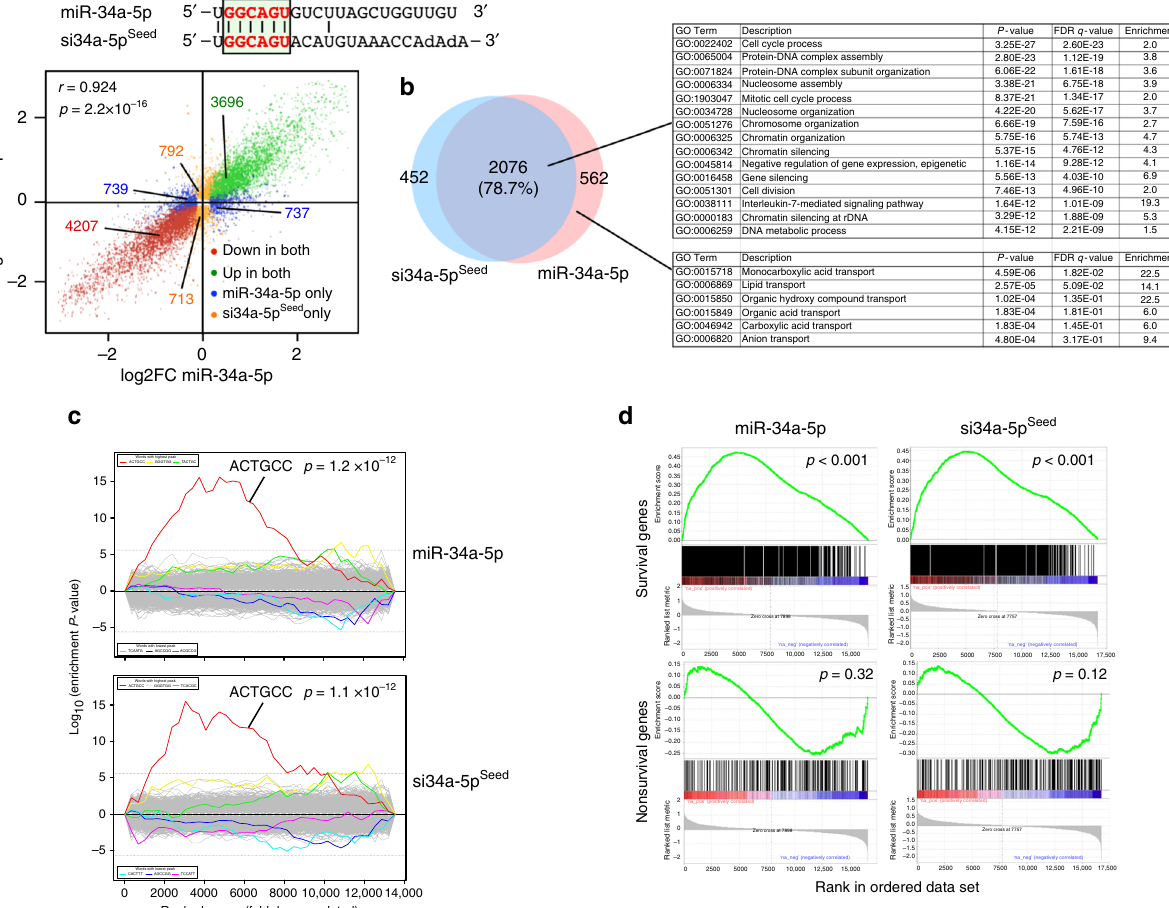
Fig. 5 miR-34a-5p kills cancer cells through its toxic 6mer seed. a Top: Alignment of the sequences of miR-34a-5p and si34a-5p Seed with the 6mer highlighted. Bottom: Comparison of deregulated mRNAs (adjusted p < 0.05, RPM > 1) in HeyA8 cells 48 h after transfection with either miR-34a-5p or si34a-5p Seed . Pearson correlation p -value is given. b Overlap of RNAs detected by RNA-Seq downregulated in HeyA8 cells (>1.5-fold) 48 h after transfection with either si34a-5p Seed or miR-34a-5p when compared to either siNT2 or a non-targeting pre-miR, respectively. Right: Results of a GOrilla gene ontology analyses of the genes downregulated in both cells transfected with miR-34a-5p or si34a-5p Seed (top, signi fi cance of enrichment <10 − 11 ), or only in cells transfected with miR-34a-5p (bottom, signi fi cance of enrichment <10 − 4 ). c Sylamer plots for the list of 3 ′ UTRs of mRNAs in cells treated with either miR-34a-5p (top) or si34a-5p Seed (bottom) sorted from downregulated to upregulated. The most highly enriched sequence is shown which, in each case, is the 6mer seed match of the introduced 6mer seed. Bonferroni-adjusted p -values are shown. d Gene set enrichment analysis for a group of 1846 survival genes (top four panels) and 416 non-survival genes (bottom two panels) 20 after transfecting HeyA8 cells with either miR-34a-5p or si34a-5p Seed . siNT1 and a non-targeting premiR served as controls, respectively. p -values indicate the signi fi cance of